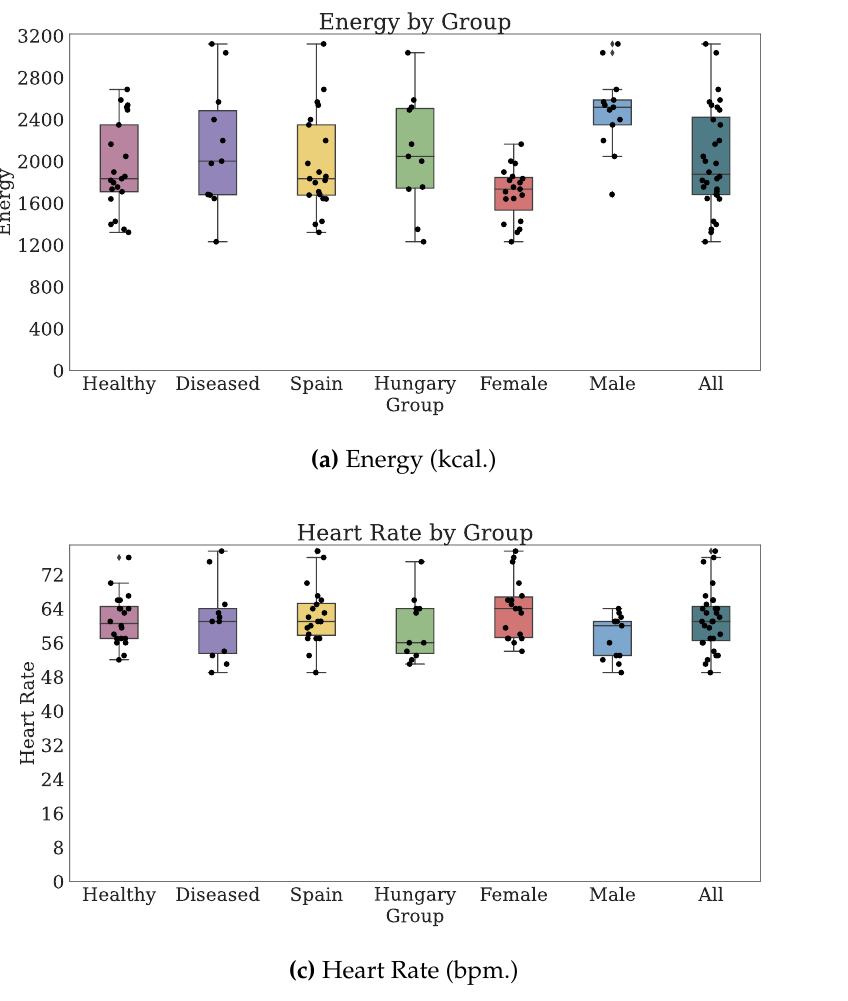
Figure 8. Median values of TechROs (Fitbit) across the entire monitoring period: energy, steps, heart rate, and sleep (1 of 2)